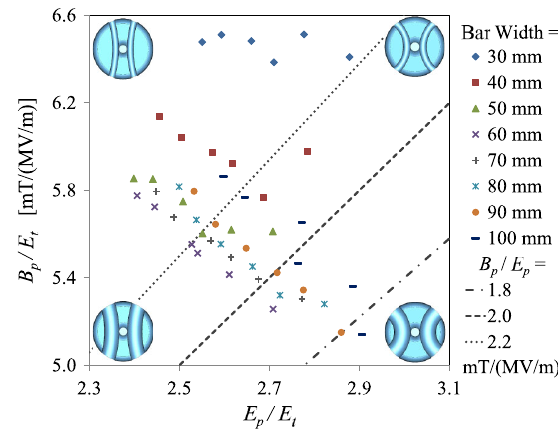
FIG. 20. Ratios of peak surface electric field ( E p ) and mag- netic field ( B p ) to the transverse electric field ( E t ) with varying bar width and radius of bar curvature for race-track-shaped curved parallel bars [Design